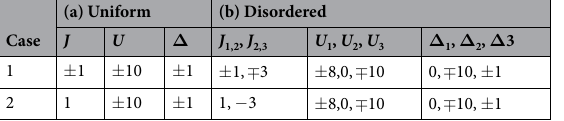
Table 1. Simulation parameters for the DDBHM trimer. Case 1 corresponds to a number-conserving transformation in which the signs of all the parameters are flipped simultaneously. Case 2 corresponds to a transformation in which the sign of the hopping energy ( J ) is kept fixed while the sign of the interaction strength ( U ) and detuning ( Δ ) are changed. γ = 1 for all cases. (a) Uniform trimer, (b) Disordered trimer with non-uniform